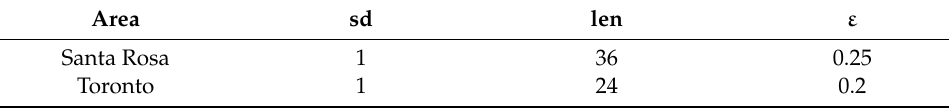
Table 2. Parameter setting of signal-based regularization.